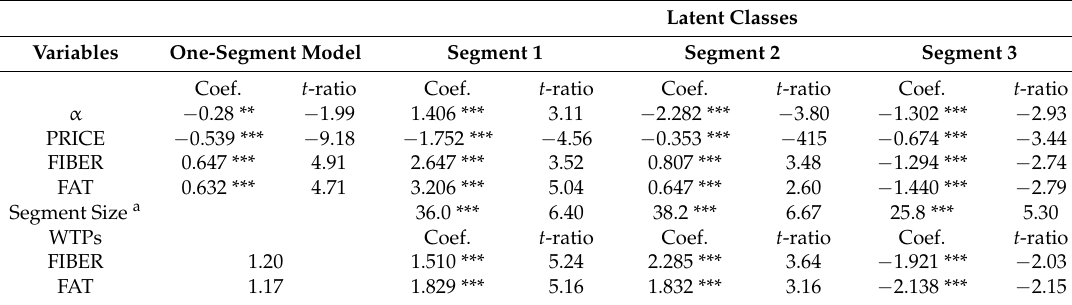
Table 4. Parameter values for biscuits latent class choice